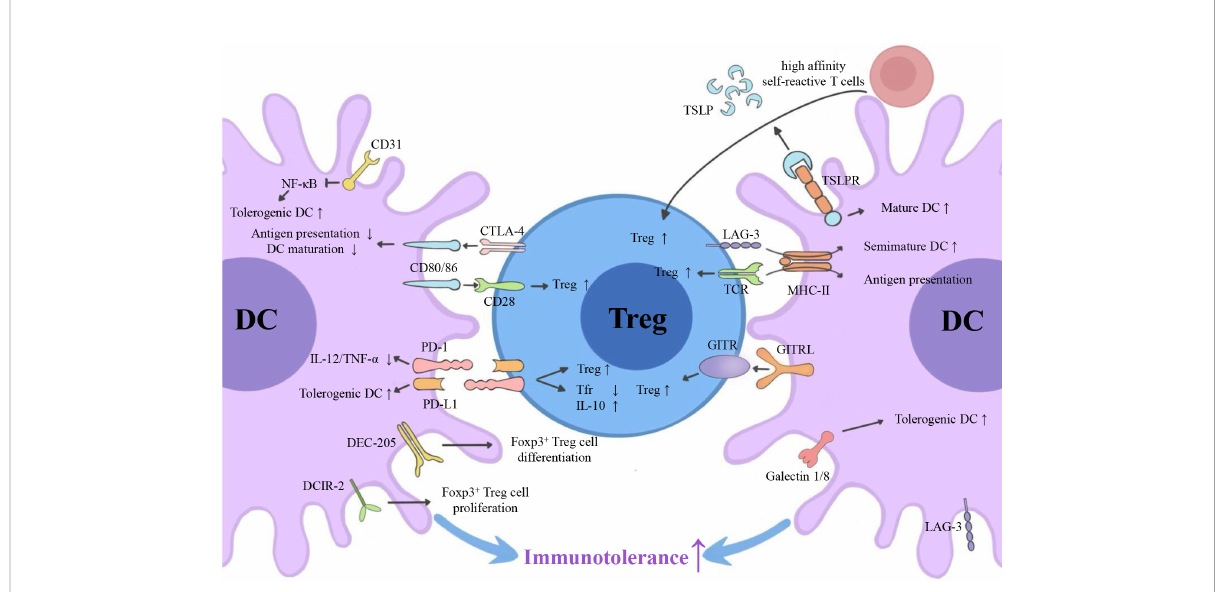
FIGURE 2 Surface molecules involved in DC-Treg cell crosstalk. Via the CD28/CTLA-4/B7 pathway, the PD-L1/PD-1 inhibitory feedback loop, and the potential LAG-3/TCR/MHC-II inhibitory feedback loop, DCs can affect the generation of Tregs, and Tregs can affect the tolerance of DCs. GITRL, TSLPR, DEC-205, DCIR-2, and CD31 are also key molecules for DC-dependent Treg cell generation. CTLA-4, cytotoxic T lymphocyte antigen 4; PD-L1, programmed cell death ligand 1; PD-1, programmed cell death receptor; LAG-3, lymphocyte activation gene 3; TCR, T cell